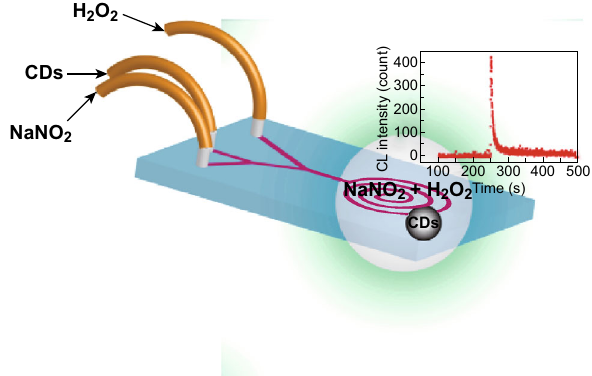
Fig. 18 Schematic design of a microfluidic chip for peroxynitrous- acid-induced CL analysis [199]. Copyright (cid:2) 2016 Elsevier